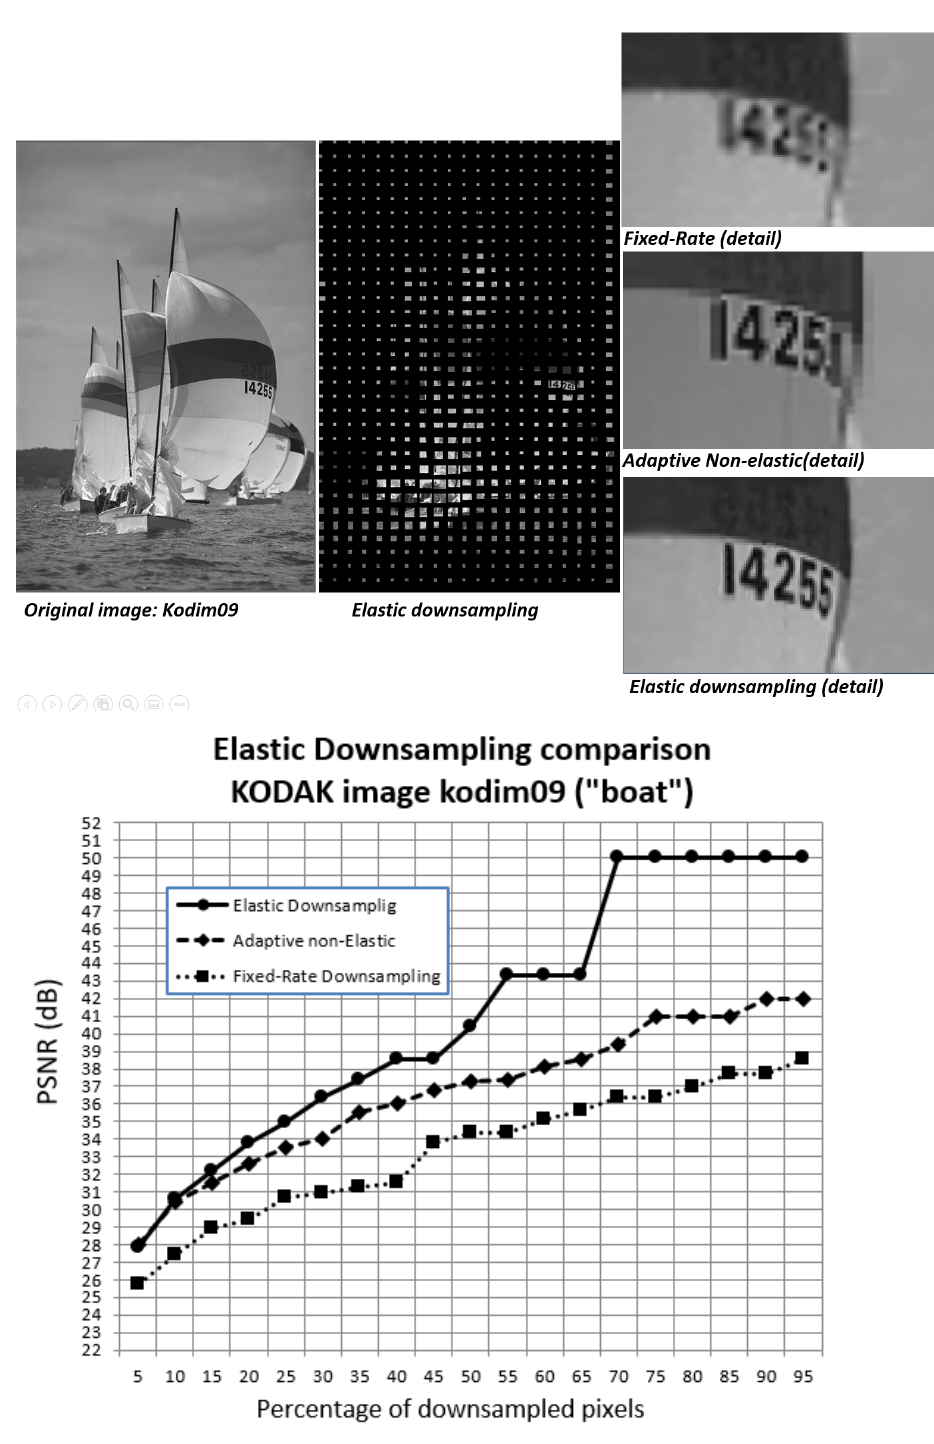
Figure 13. Elastic downsampling results for the “boat” image. The same visual comparison for the image “motorcycles” is shown at Figure 14. In this case the advantage is not so extreme but is clear and the helmet details are better protected with elastic downsampling. For both images (boat and motorcycles), there are no blocking effects nor artifacts present, thanks to the smooth sample rate evolution, which is a benefit of elastic